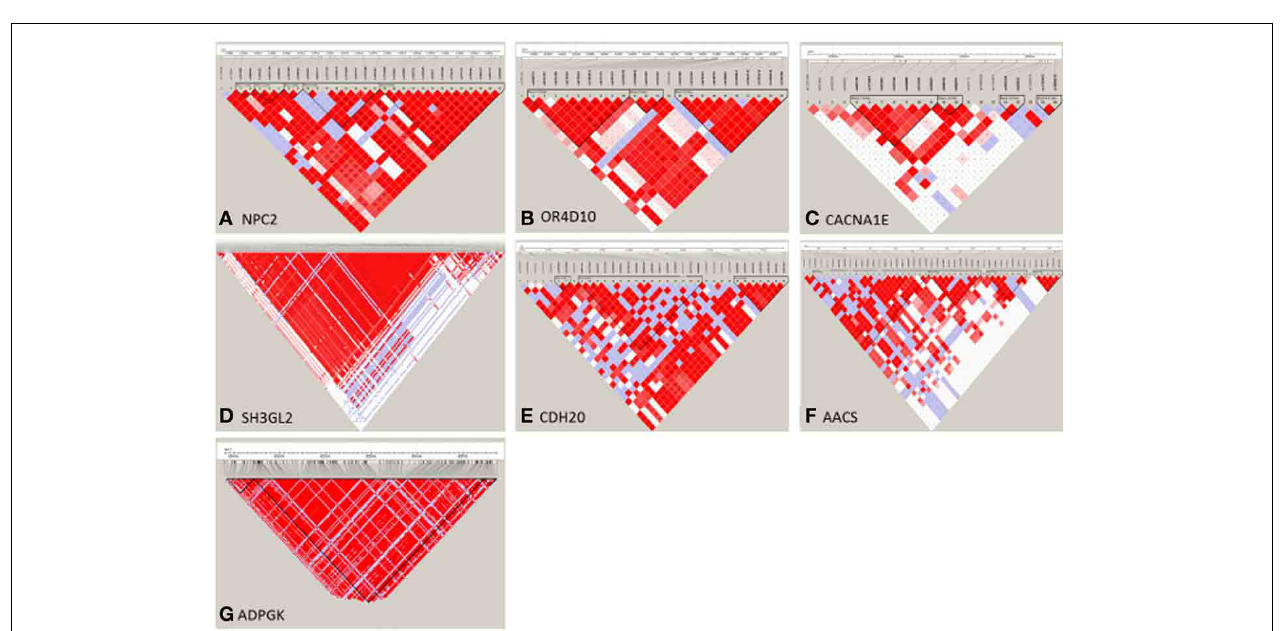
FIGURE 3 | LDLA regional plots for regions around seven selected genes. The concerning gene is vertically marked with a gray bar. The blue dash line indicates a suggestive significance threshold with